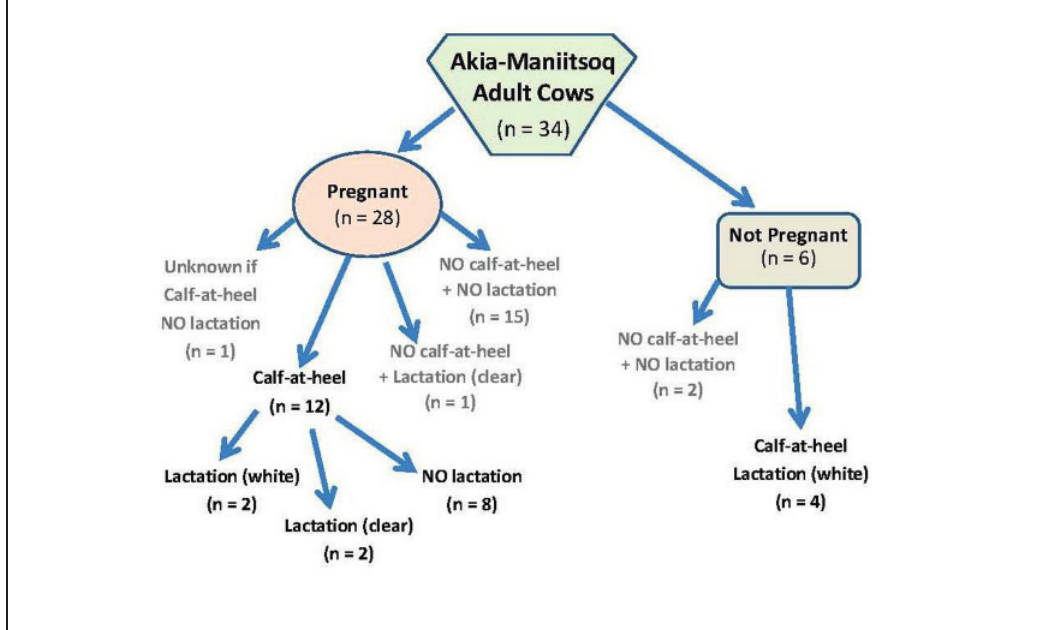
Fig. 2. Reproductive status among the adult cows from the Akia-Maniitsoq caribou herd of West Greenland collected from 29 March to 13 April 2008.